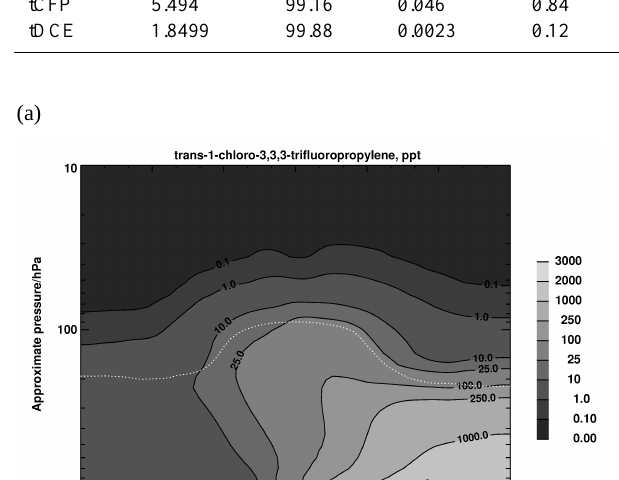
ranges from the North Polar lower stratosphere to the tropics. Comparison to the tCFP perturbation in Fig. 1a suggests that about half of the Cl y perturbation from tCFP is due to Cl y transport from the